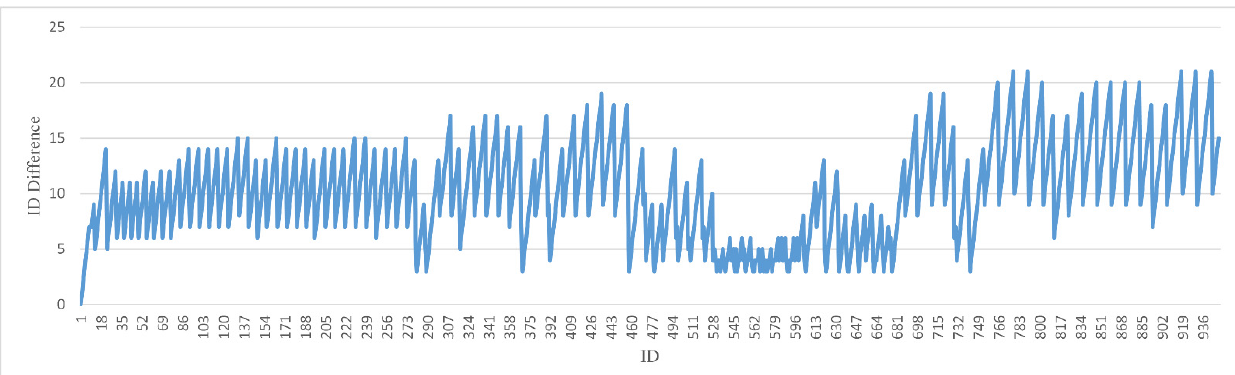
Figure 13. The difference between the oldest keyframe ID and the current frame ID.